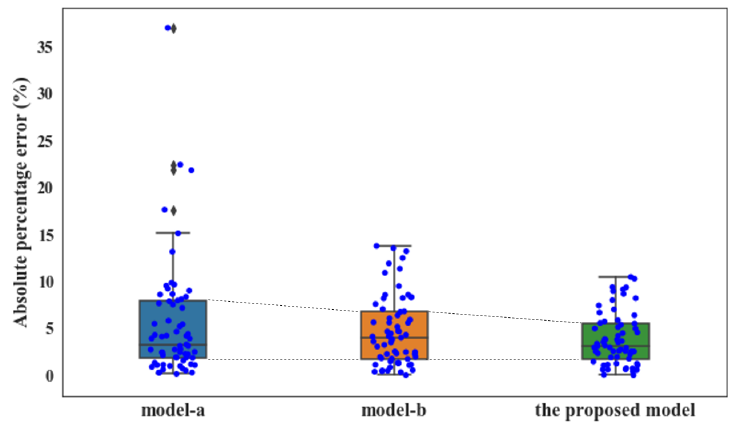
Figure 9. Boxplot of error on testing set obtained by different inputs.